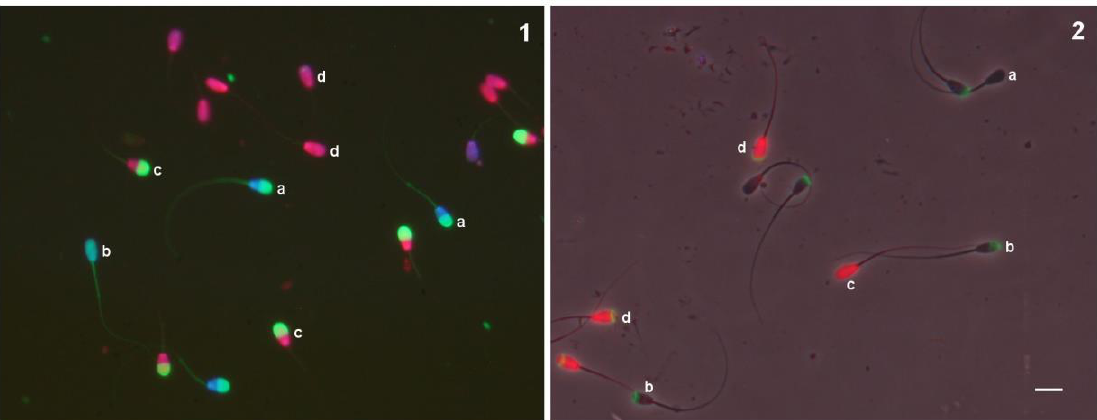
Figure 1. Fluorescence image of bull spermatozoa stained with ISAS3Fun kit ( 1 ) and fluorescence-phase contrast image of bull spermatozoa stained with PI/PNA. ( 2 ): a, Intact plasma membrane and acrosome; b, intact plasma membrane and damaged acrosome; c, damaged plasma membrane and intact acrosome; d, damaged plasma membrane and acrosome. Scale bar = 10 µm.